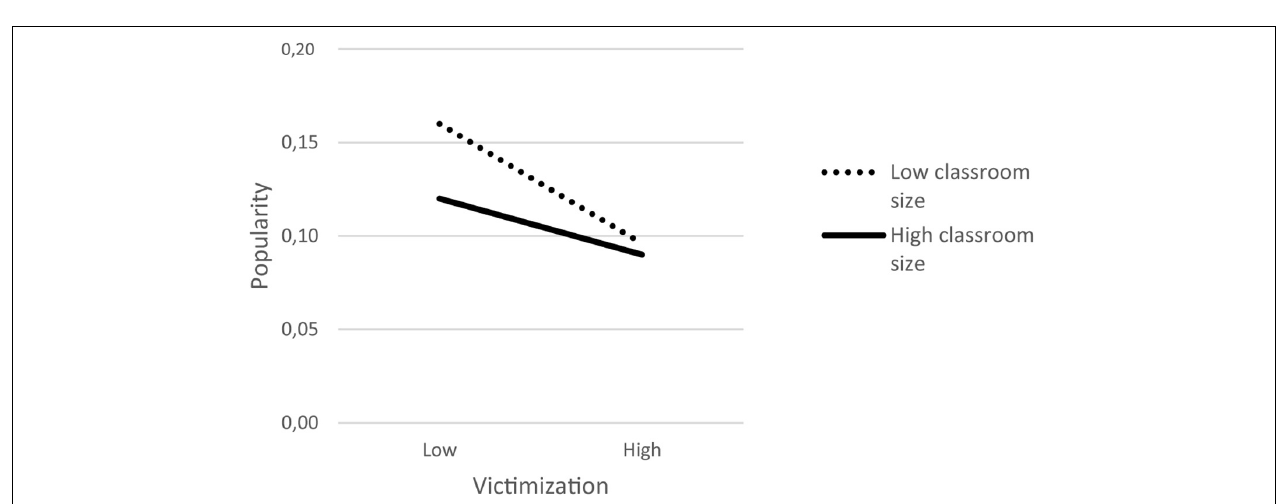
FIGURE 1 | Moderating effects of classroom size on the association between classroom mean-centered self-reported bullying and popularity in the Austrian sample. Cut-offs of 1SD above and below the mean were used to represent the level of popularity of adolescents low and high in self-reported bullying, in small classrooms ( ∼ 14 students) and in large classrooms ( ∼ 23 students).